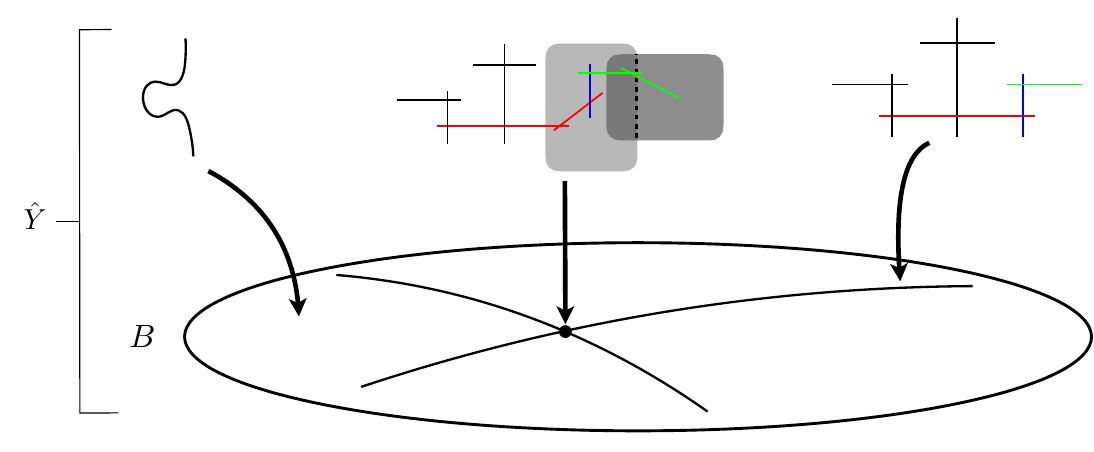
Figure 1 . A cartoon illustrating the splitting of (cid:12)bers after blowing up the non-minimal singularity over a point of the base. The gray squares represent the surface components of the non-(cid:13)at (cid:12)ber. In general, codimension one (cid:12)bers can split into several curves which all (green) or only partly (red) lie inside the surfaces. They can also remain irreducible, and sit inside (blue) or outside (black) of any surface. By blowing down the surfaces to a point, the blue and green (cid:12)bral curves are forced to shrink over the codimension one loci of the base. In the case depicted here, this would lead to an enhancement of an SU(3) subgroup of the full E 6 (cid:13)avor